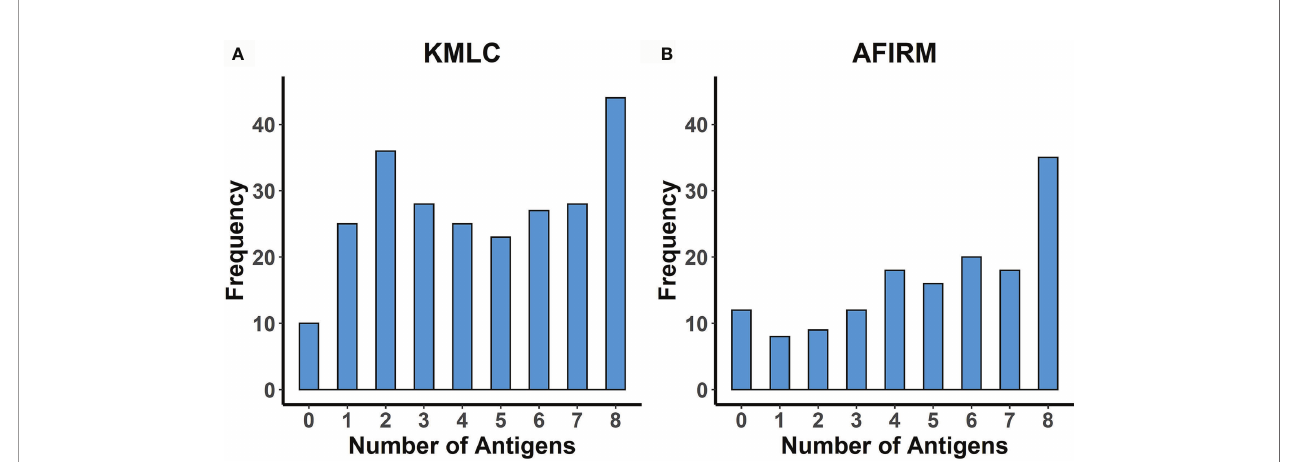
FIGURE 5 | | Breadth of response to the eight gametocyte proteins. Histograms showing the number of study participants seropositive to an increasing number of the proteins studied (limited to participants with responses measured to all eight proteins). (A) KMLC (N = 246) and (B) AFIRM cohort (N = 148).